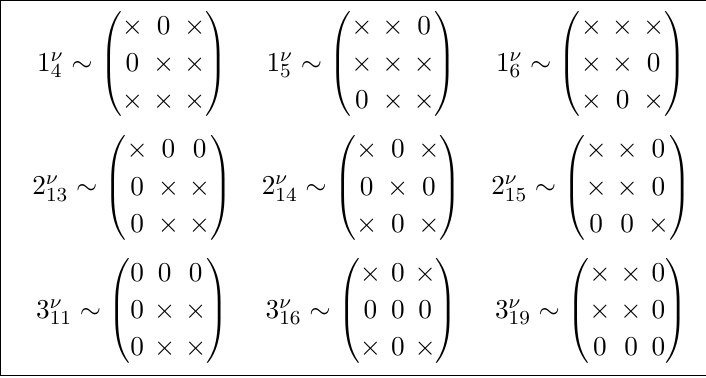
Table 4 . Textures for the effective neutrino mass matrix M eff